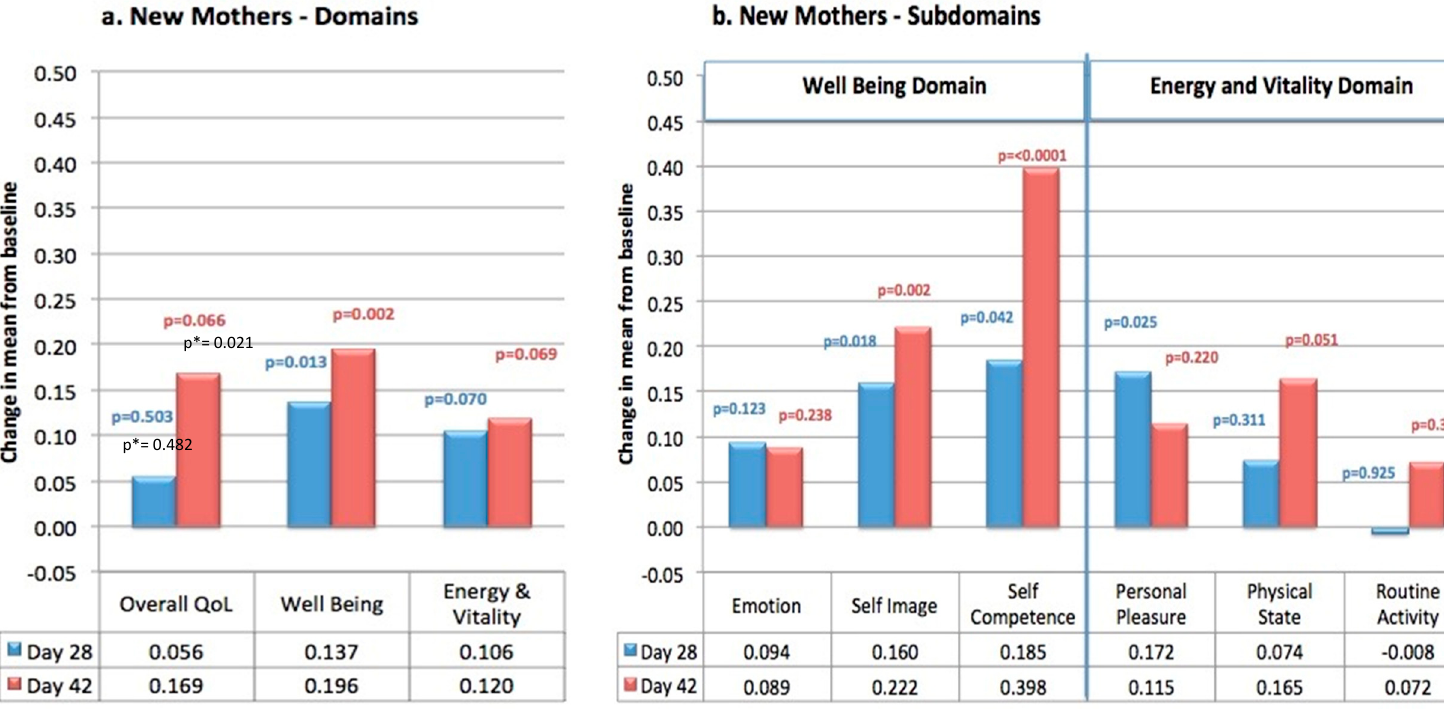
Figure 2. The FQoL ™ instrument was administered at three total time points. Mean scores for domains ( a ) and subdomains ( b ) were determined at 28- and 42-days and compared to the baseline means for significant changes using a t test. The 2-tailed p values are reported. In this group, 89 participants completed day 28, and 83 completed day 42. For Overall QoL, the p -values from non-parametric tests are also reported and denoted by p *.